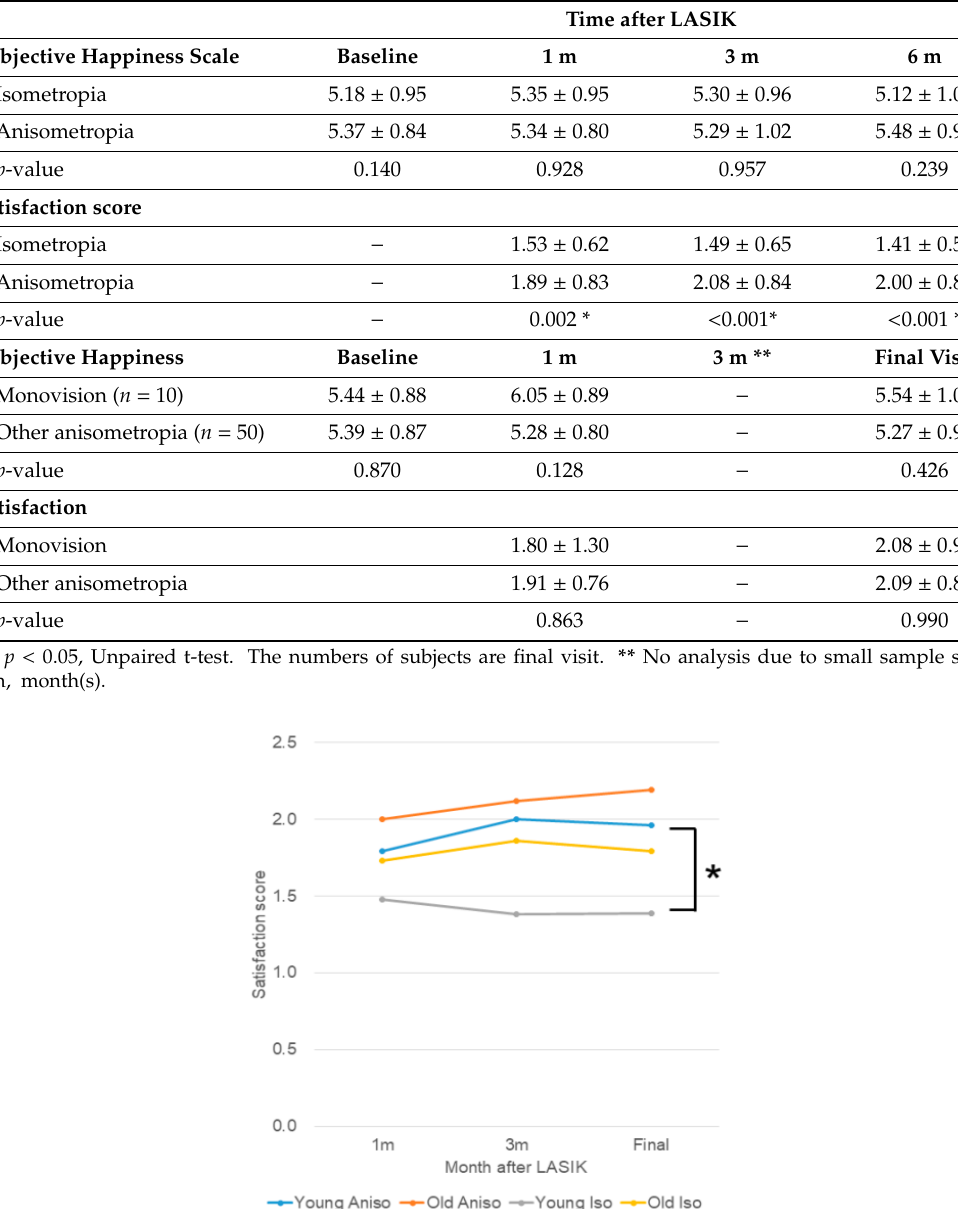
Table 4. Subjective happiness scale and satisfaction in isometropic and anisometropic participants.